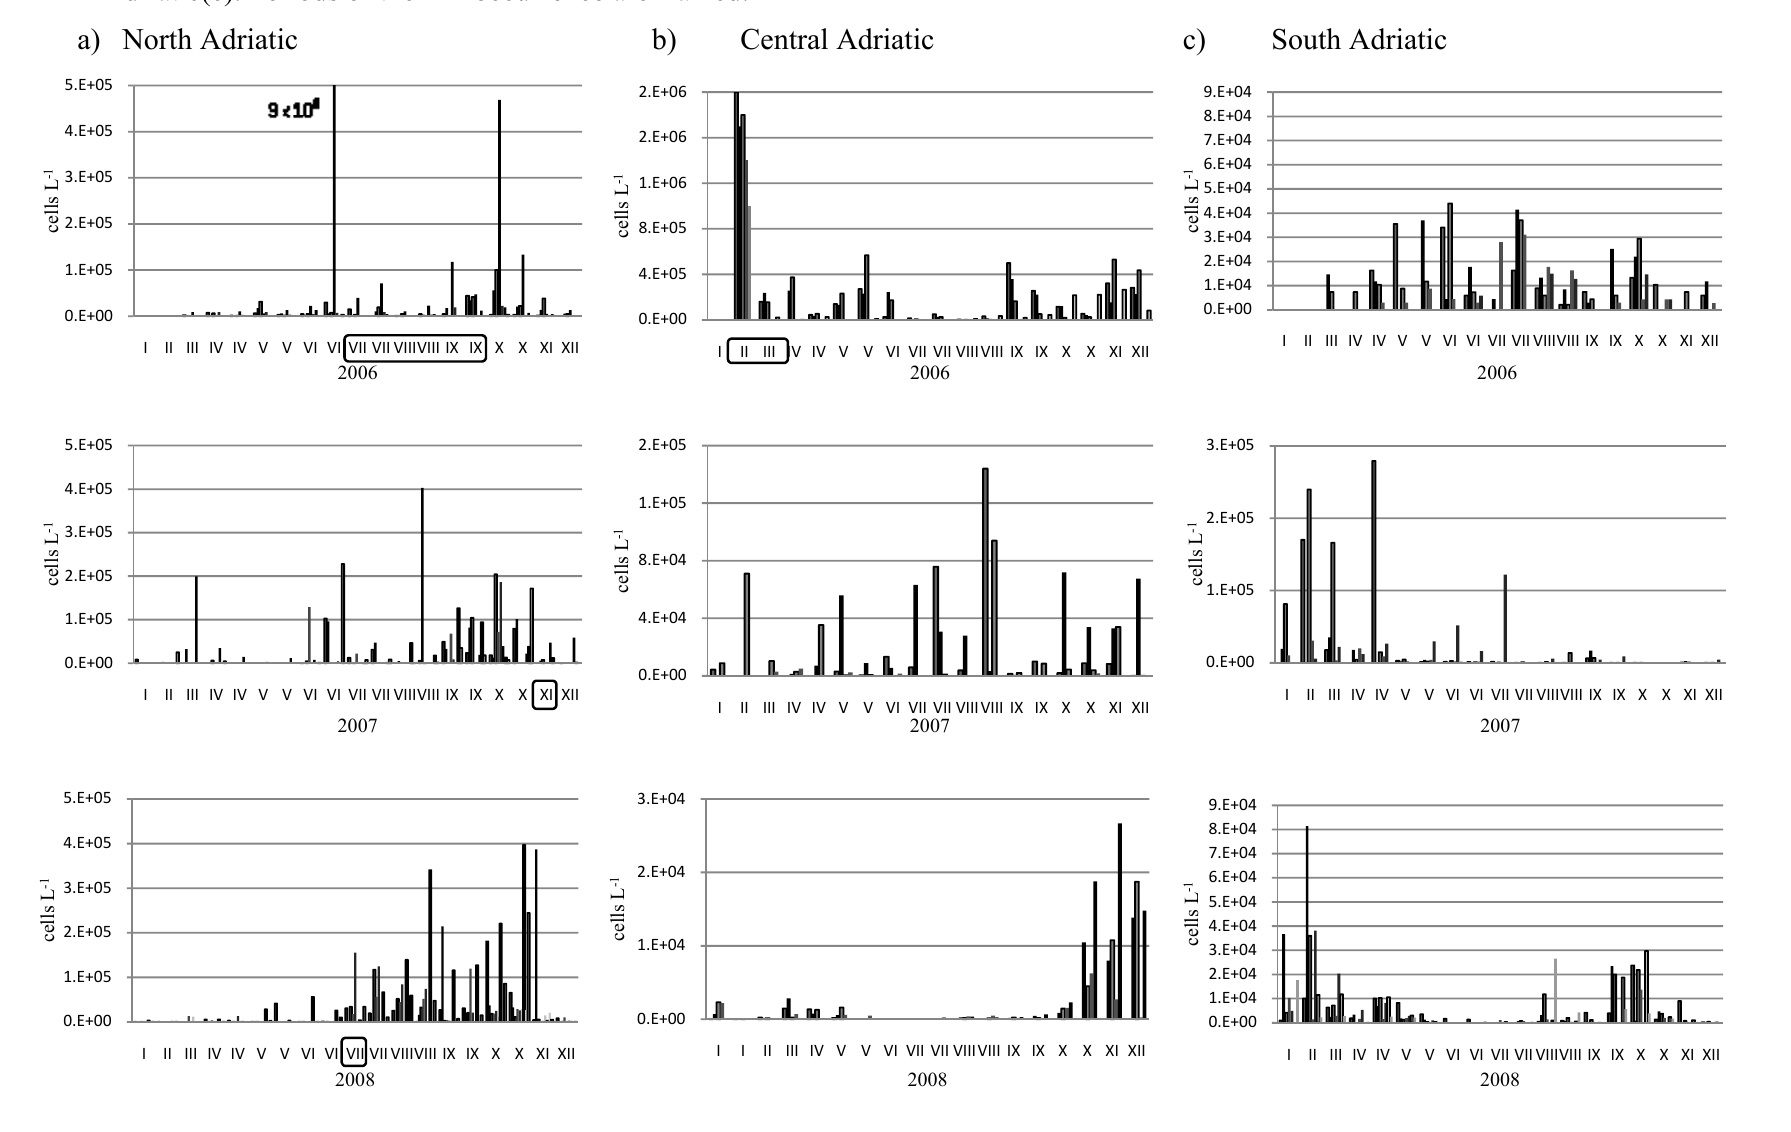
Figure 3. Annual variability of Pseudo-nitschia spp. number of cells from North Adriatic (a), Central Adriatic (b) and South Adriatic(c). Periods of the DA occurrence are